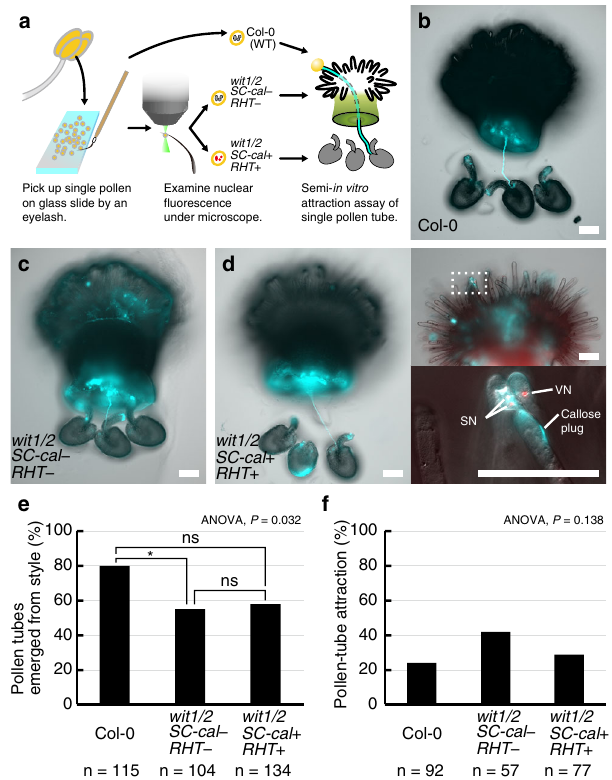
Fig. 8 Guidance of pollen tubes containing immotile vegetative nucleus and sperm cells. a Schematic drawing of the single pollen-tube guidance assay. b – d Representative images of ovular-targeting pollen tubes visualized by aniline blue staining after the single pollen-tube guidance assay. Pollen tubes from wild-type Col-0 pollen (Col-0, b ). Pollen tubes from tdTomato-negative pollen ( wit1/2 SC-cal − RHT − , c ) or tdTomato- positive pollen ( wit1/2 SC-cal + RHT + , d ) from a wit1 wit2 mutant line hemizygous for genetically linked pHTR10:cals3m and pRPS5A:H2B-tdTomato (identical to the wit1/2 SC-cal RHT line shown in Fig. 5). The right panels in ( d ) represent the RHT + pollen tube on the stigma; magni fi cation of the dashed box in the upper-right is shown in the lower-right. Scale bar: 100 μ m. Images are representative of 22 ( b ), 24 ( c ), or 22 ( d ) independent assays showing similar patterns. e Percentage of pollen tubes that emerged from the cut style. f Percentages of pollen tubes that entered the micropyle in the ovules. Statistical test: Bonferroni-adjusted signi fi cance test was performed after one-way ANOVA. Asterisk indicates signi fi cance ( P =